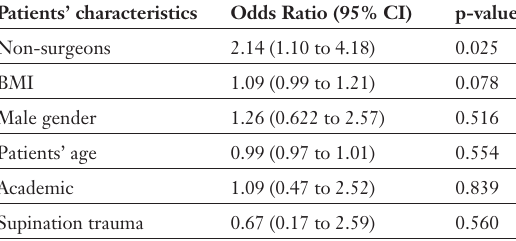
Shows the results of a multivariate model assessing the association between surgical experience and false positive results when correcting for various patients’ characteristics.